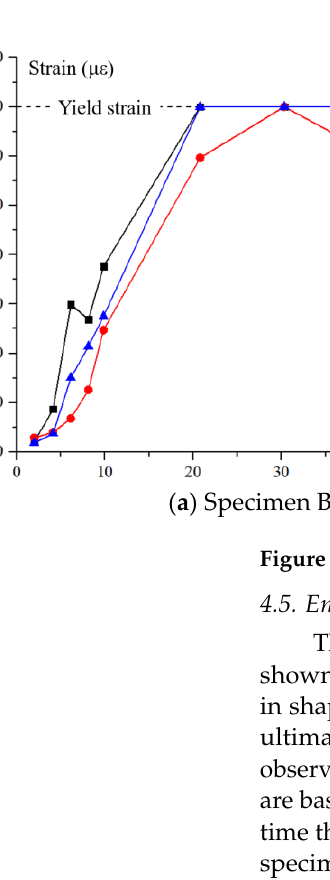
Figure 22. Envelope curves of specimen.